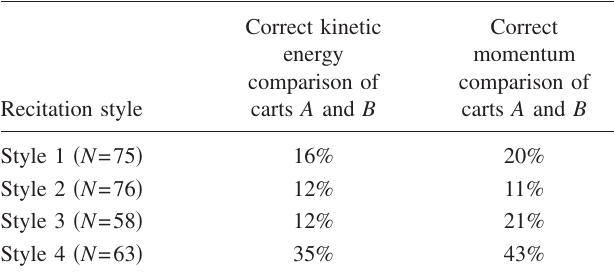
TABLE V. Students who continued to use same incorrect rea- soning on pre- and post-test question 1.